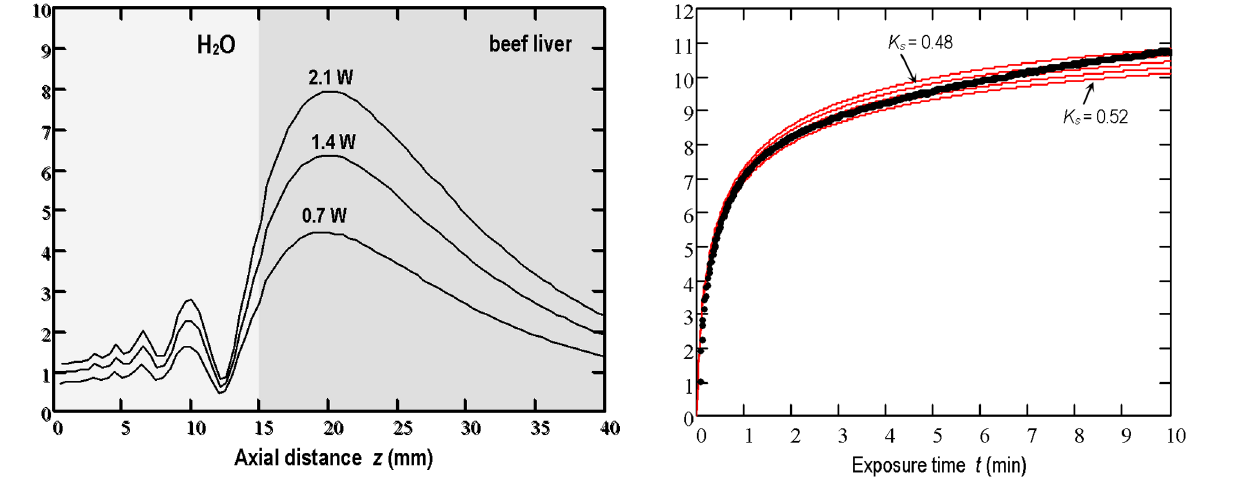
higher temperatures as well as the tissue heterogeneity. Finally, the measured and simulated results is the accuracy of positioning (especially in radial direction) of the thermocouple on the acoustic beam axis at the point of maximum heating.